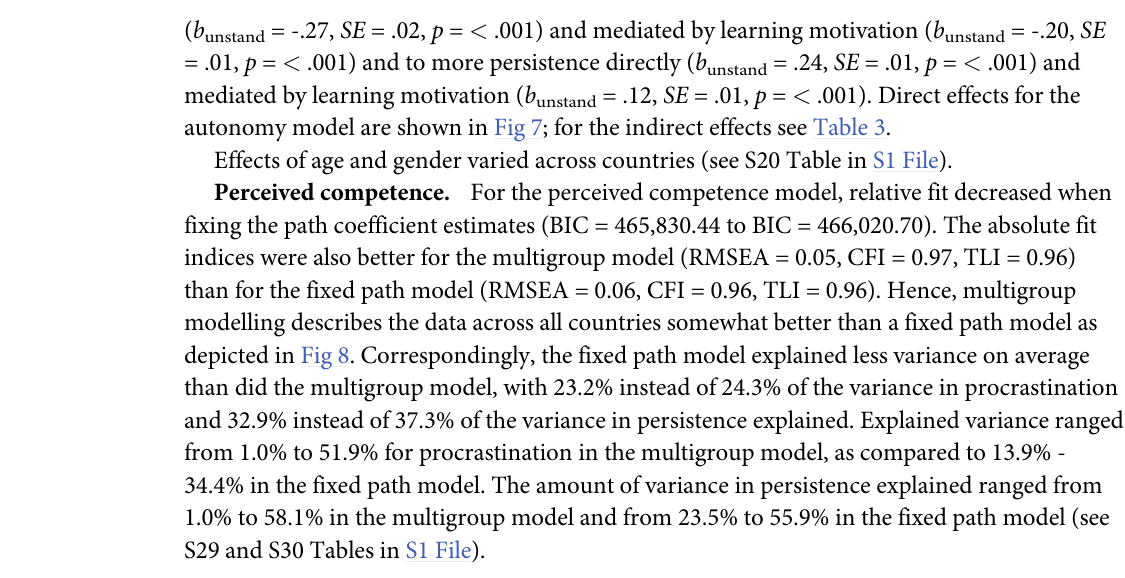
Fig 7. Latent structural path model of the direct effects between perceived autonomy, intrinsic motivation, procrastination, and persistence, with average coefficients across all countries. ��� p = < .001.